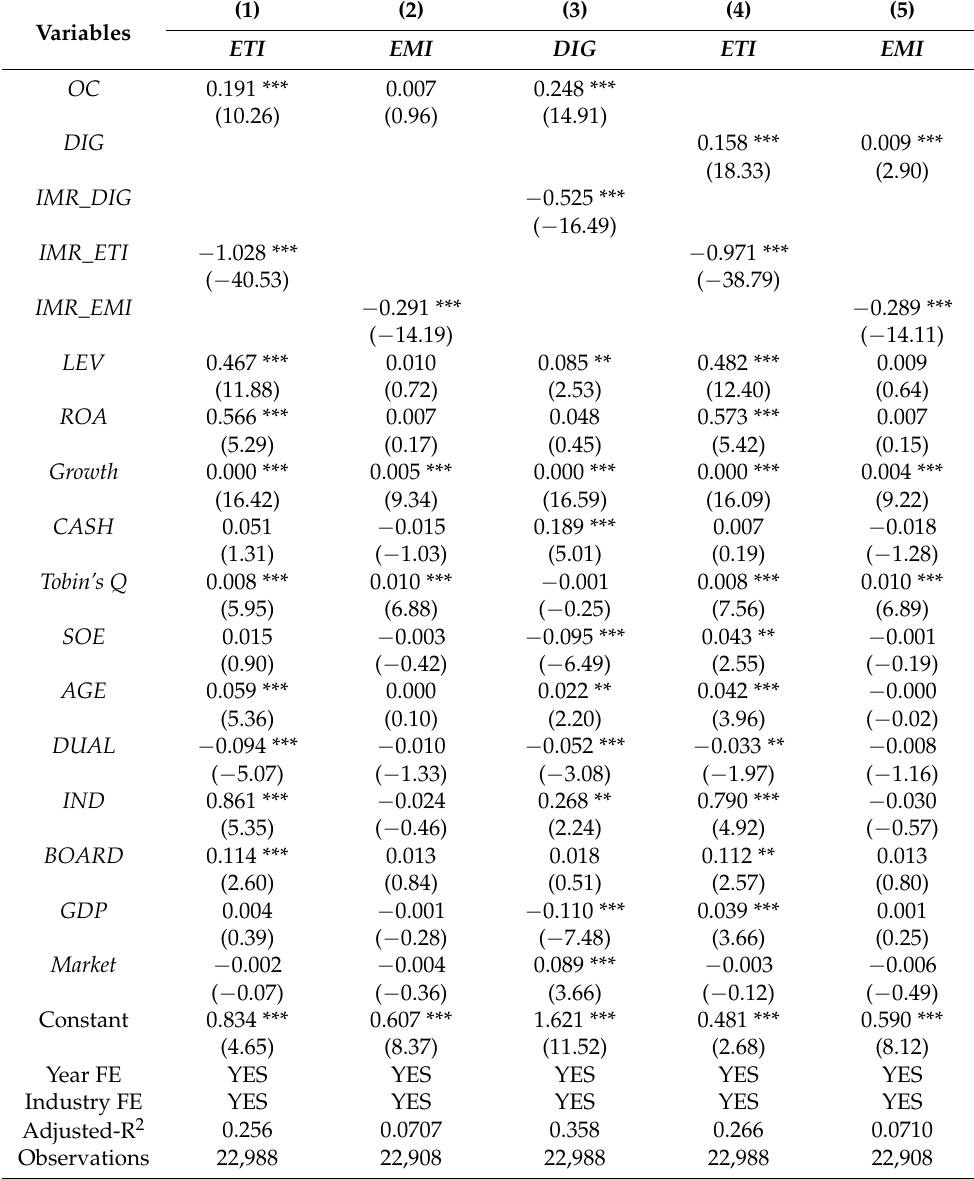
Table 6. Endogenous test of the Heckman two-stage